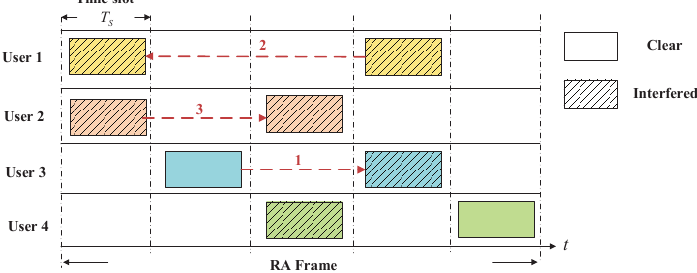
Figure 2. Contention resolution diversity slotted Aloha (CRDSA) frame structure and interference cancellation procedure (Packet replica l =